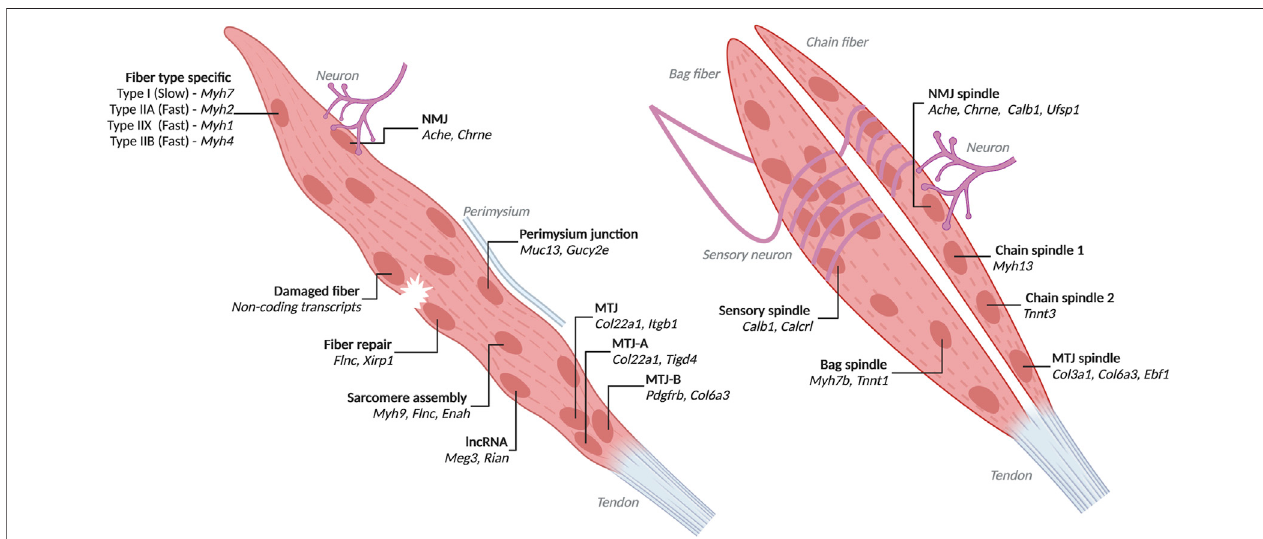
FIGURE 2 | Heterogenous myo fi ber nuclei with associated markers identi fi ed by high-throughput transcriptomics Populations and top markers of nuclei from myo fi bers identi fi ed through single-nucleus RNA-seq and low throughput spatial transcriptomics. Left is a generic myo fi ber with transcriptionally distinct nuclei labelled. All populationsexcept fi ber type speci fi c,sarcomereassemblyand lncRNA arein fl uenced bytheirproximity toothercells, damageor theperimysium. Right arebagand chain fi bers. Created with